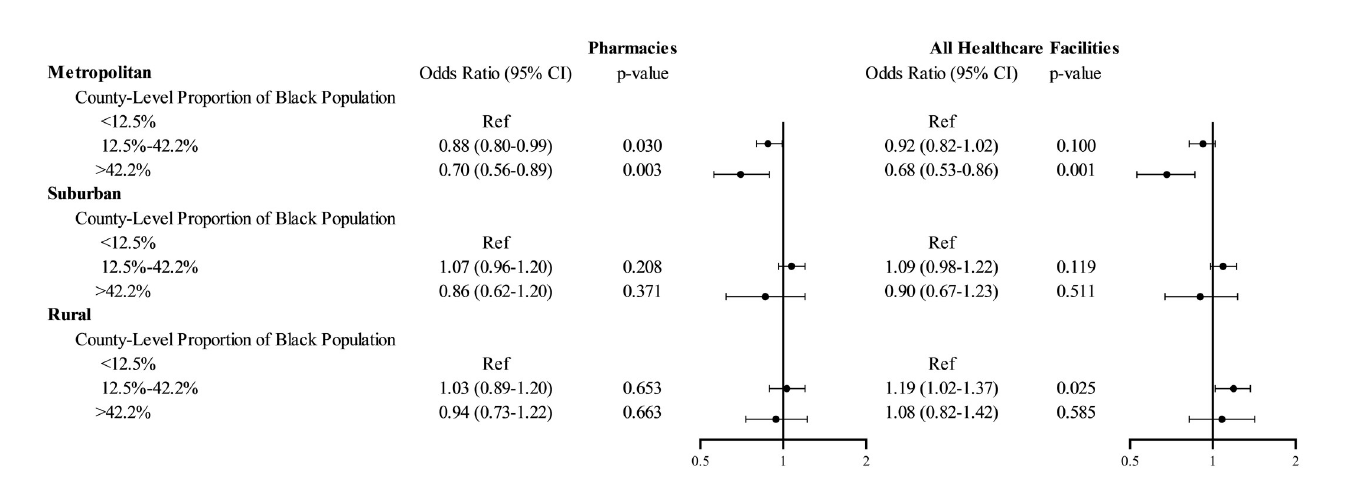
Fig 2. Adjusted odds ratios of facilities serving as COVID-19 vaccine administration locations, interaction for proportion non-Hispanic Black population and urbanicity. The figure shows the results of logistic regression models fitted with generalized estimating equations for the primary outcome of a healthcare facility (or a pharmacy) serving as a COVID-19 vaccine administration location. All healthcare facilities included pharmacies, FQHCs, RHCs, and HODs. The model adjusted for all covariates listed in Fig 1. Additionally, the model constructed for all healthcare facilities included an indicator variable for facility type (pharmacy vs. others). The circles represent the point estimate for the odds ratio, and the whiskers represent the 95% confidence interval. COVID-19, Coronavirus Disease 2019; FQHC, federally qualified health center; HOD, hospital outpatient department; RHC, rural health clinic.